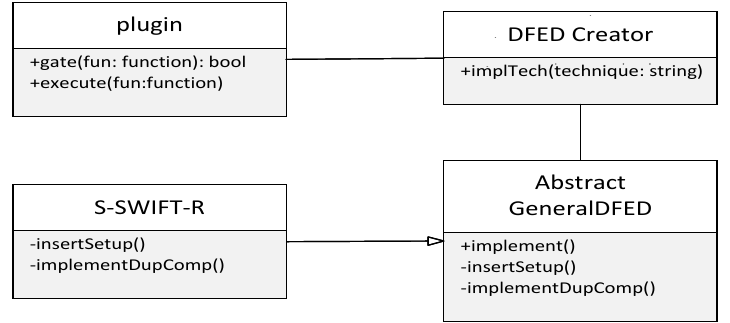
Figure 2. UML class diagram of the S-SWIFT-R compiler